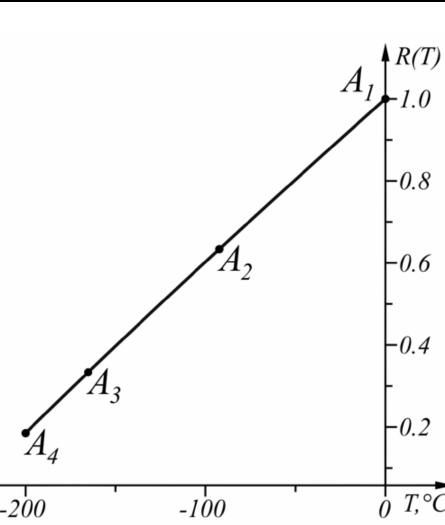
Figure 10. Graphical results of the solution in the range T ∈ [ − 200, 0 ] ◦ C.